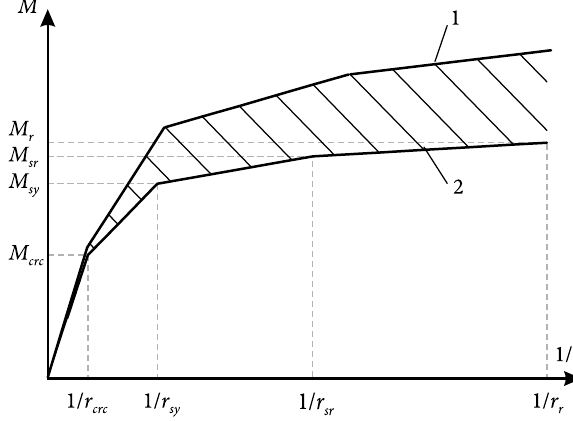
Fig. 3. Relationship between deflection and bending moment: